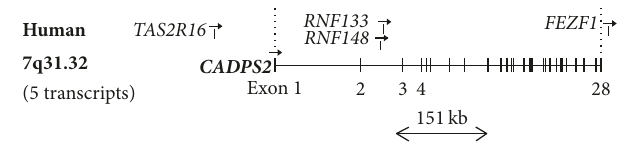
Figure 4: Exon-intron structure of the human CADPS2/CAPS2 gene located on 7q31.32 and the approximate location of the 151kb mutation found in the case